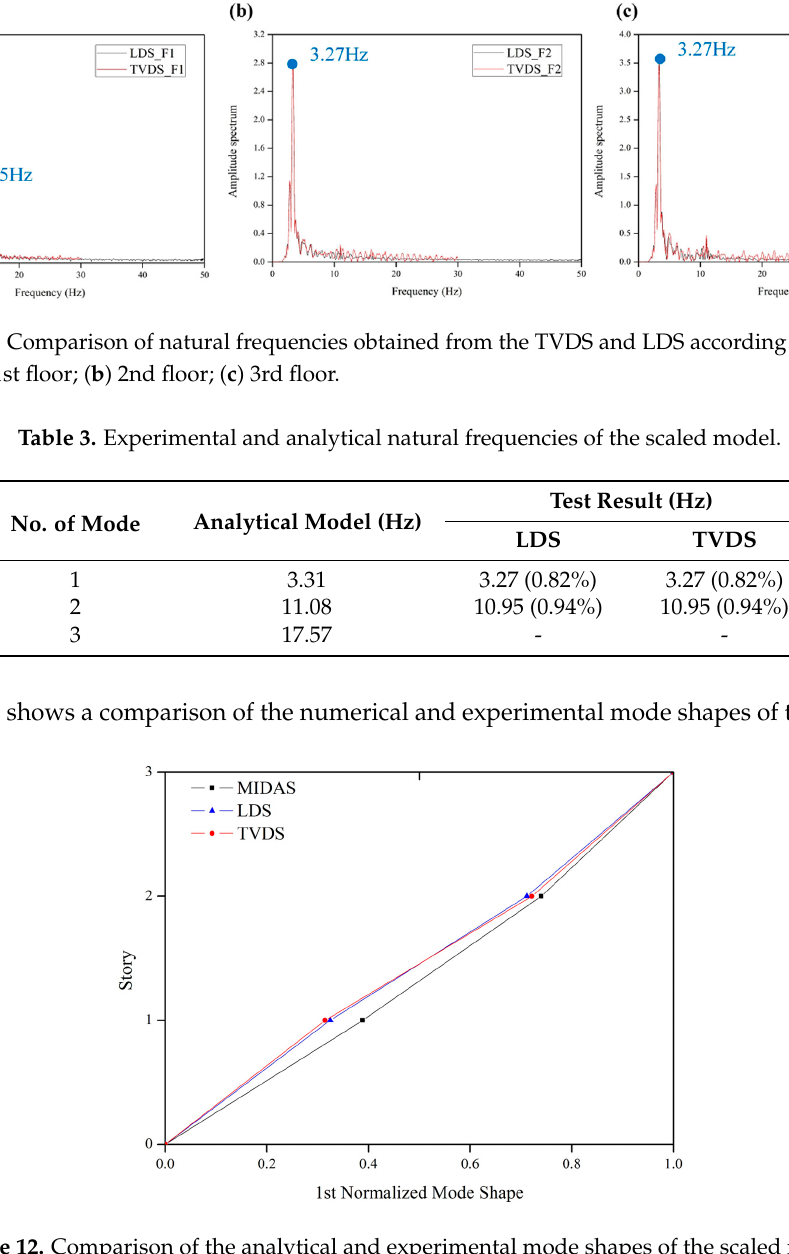
Figure 12. Comparison of the analytical and experimental mode shapes of the scaled model.